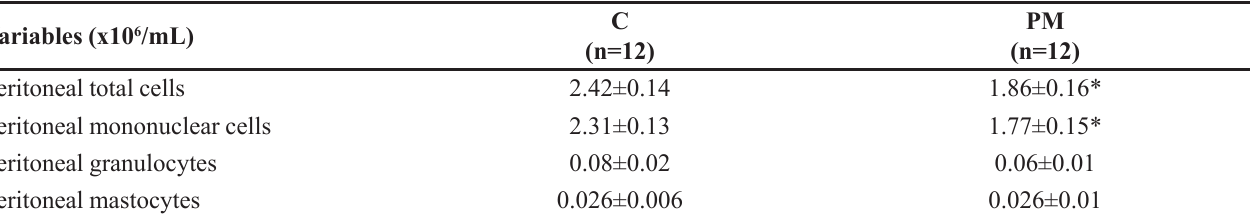
TABLE II - Total cell numbers and different types of cells in peritoneal exudates from control (C) and protein malnourished (PM)